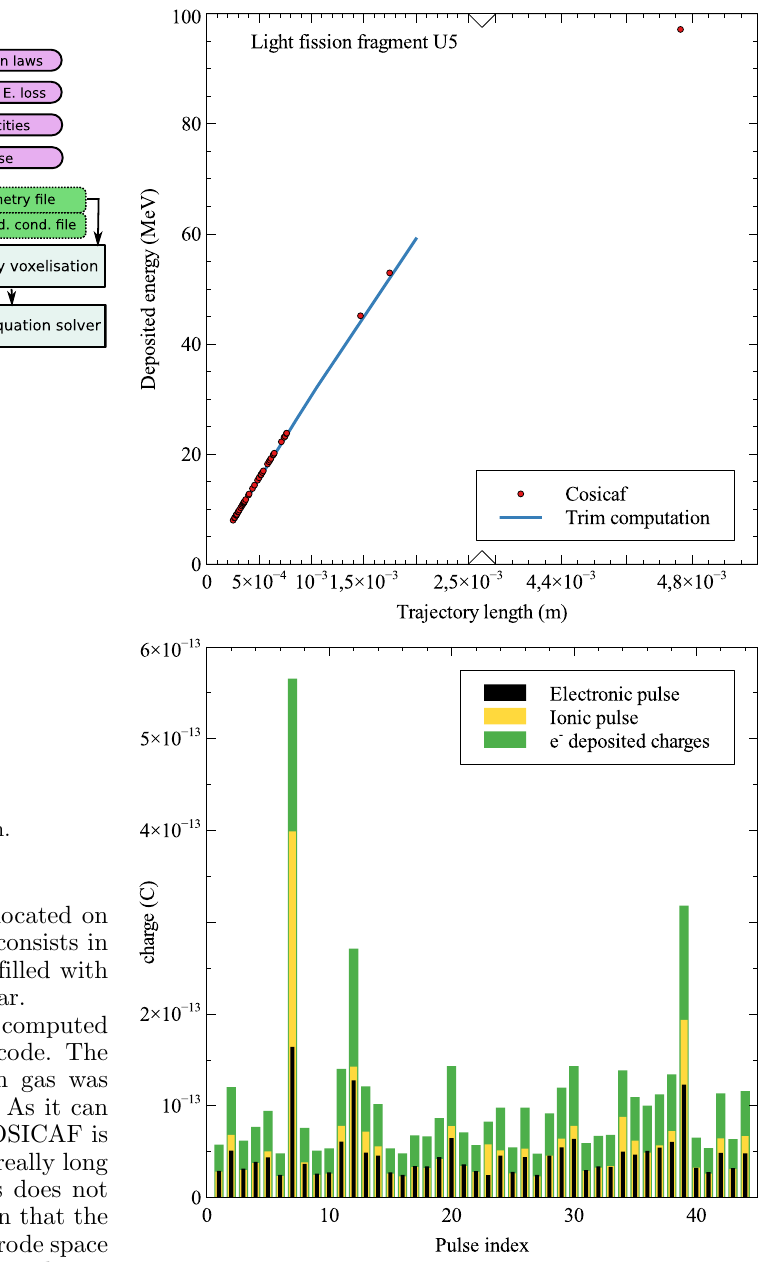
Fig. 11. Top: comparison between COSICAF and TRIM energy deposition for various trajectories. The straight trajec- tory hypothesis fails only for long trajectories. Bottom: charges induced by electrons (black) and ions (yellow) at the electrode compared to the total amount of electron charge generated by the heavy ion in the inter-electrode gap